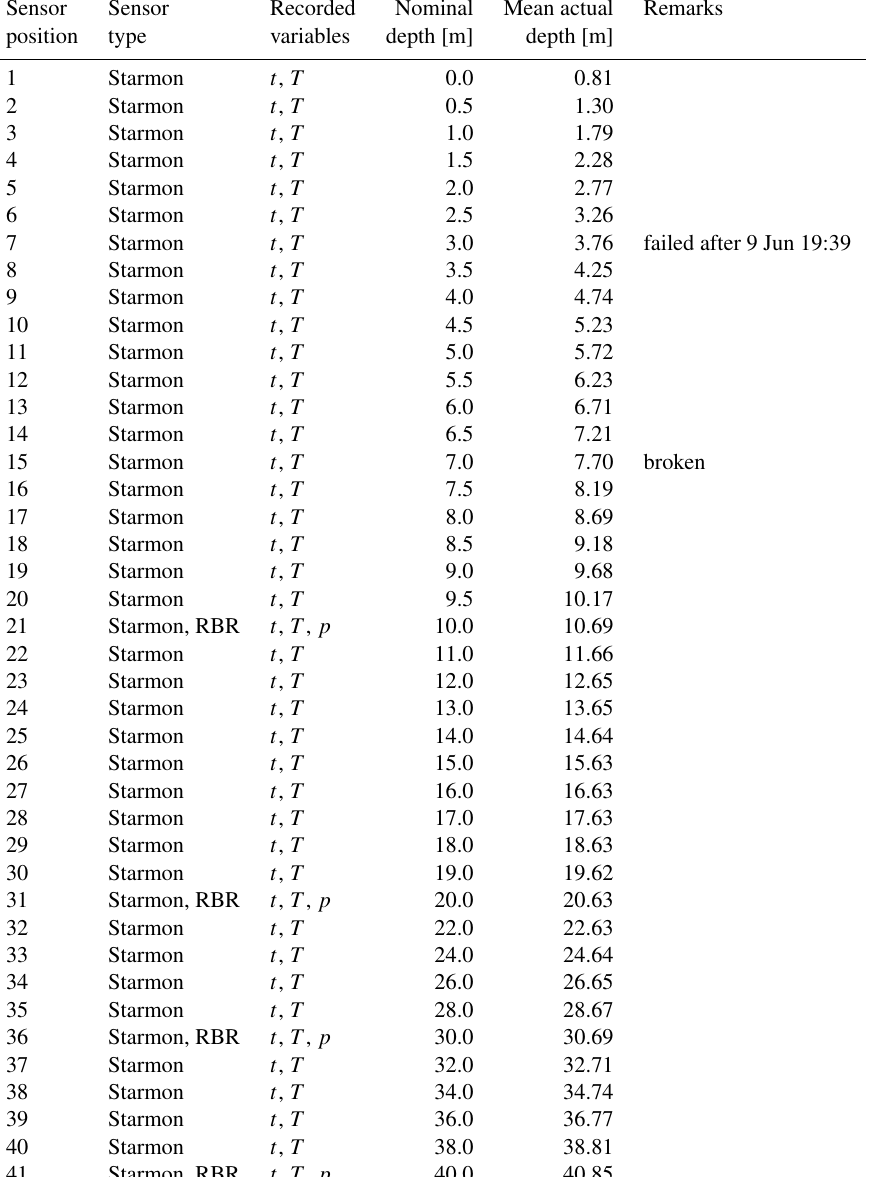
Table 1. The nominal and actual depths of the Starmon and RBR sensors mounted on the appendix of mooring M1. For the meaning of the recorded variables, see the